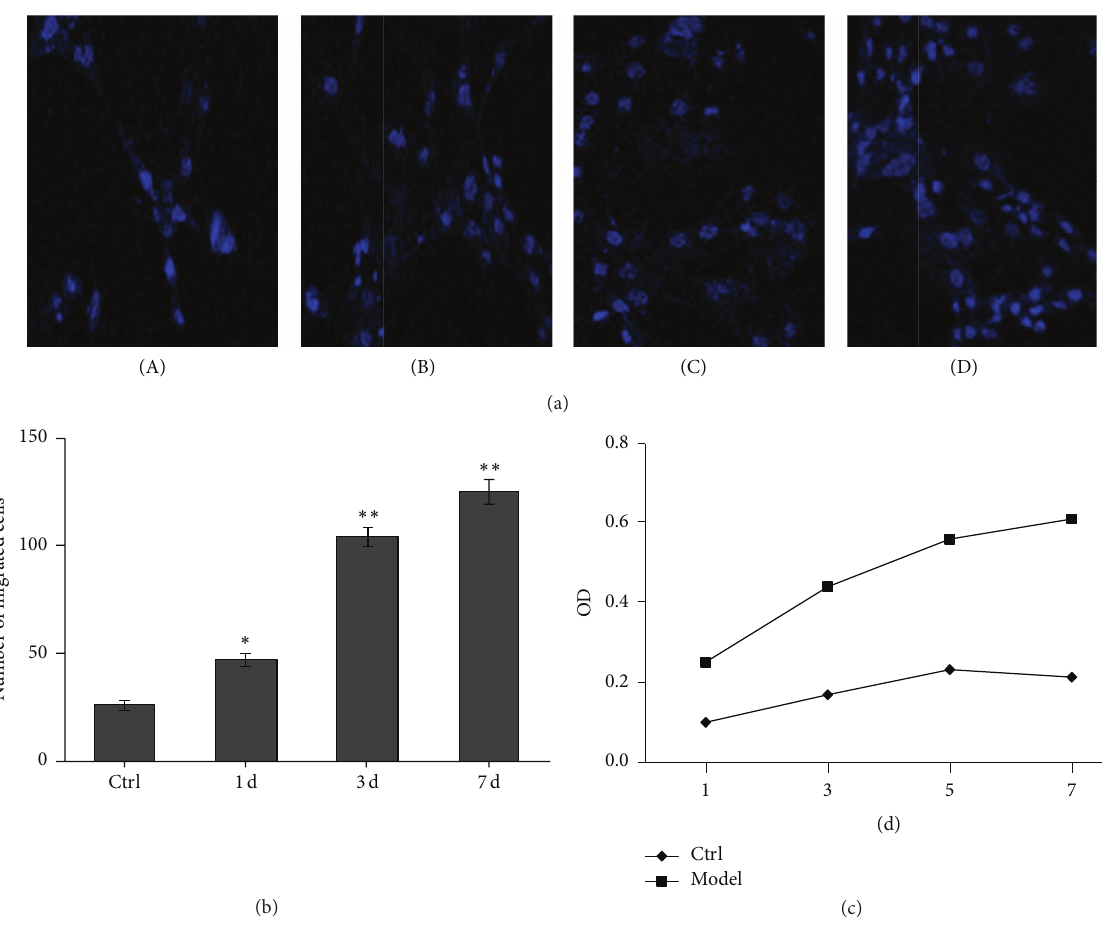
Figure 4: Migration and proliferation of BMSCs. (a) Migration of BMSCs. (A) BMSCs cultured alone for 7 days served as controls ( × 200). (B–D) Immunofluorescence expressions of BMSCs exhibited a blue-stained nucleus after coculture for 1, 3, or 7 days. (b) The number of migrated cells in every group. ∗ 𝑃 < 0.05 compared to the control (model versus control, ∗ 𝑃 < 0.05 ; the model group for 3 days or 7 days versus 1 day, ∗∗ 𝑃 < 0.05 ). (c) Proliferation rates curve of BMSCs in various